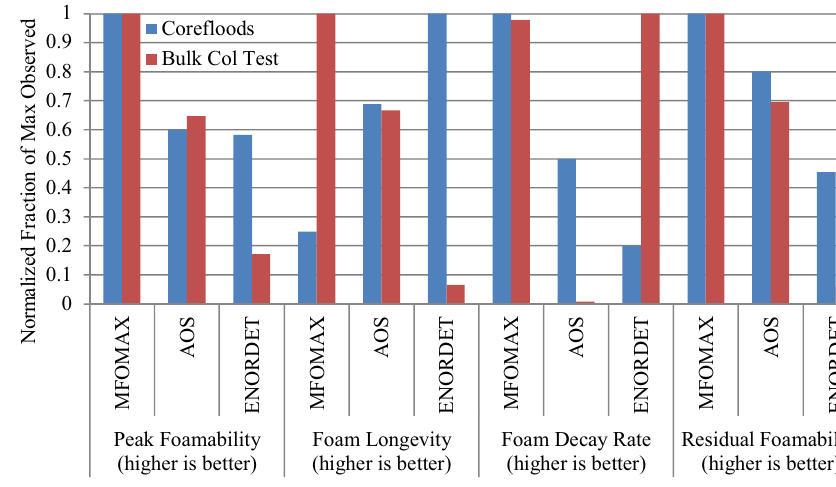
Table 9 Comparison of normalized foaming attributes between corefloods and bulk foam stability tests Attribute